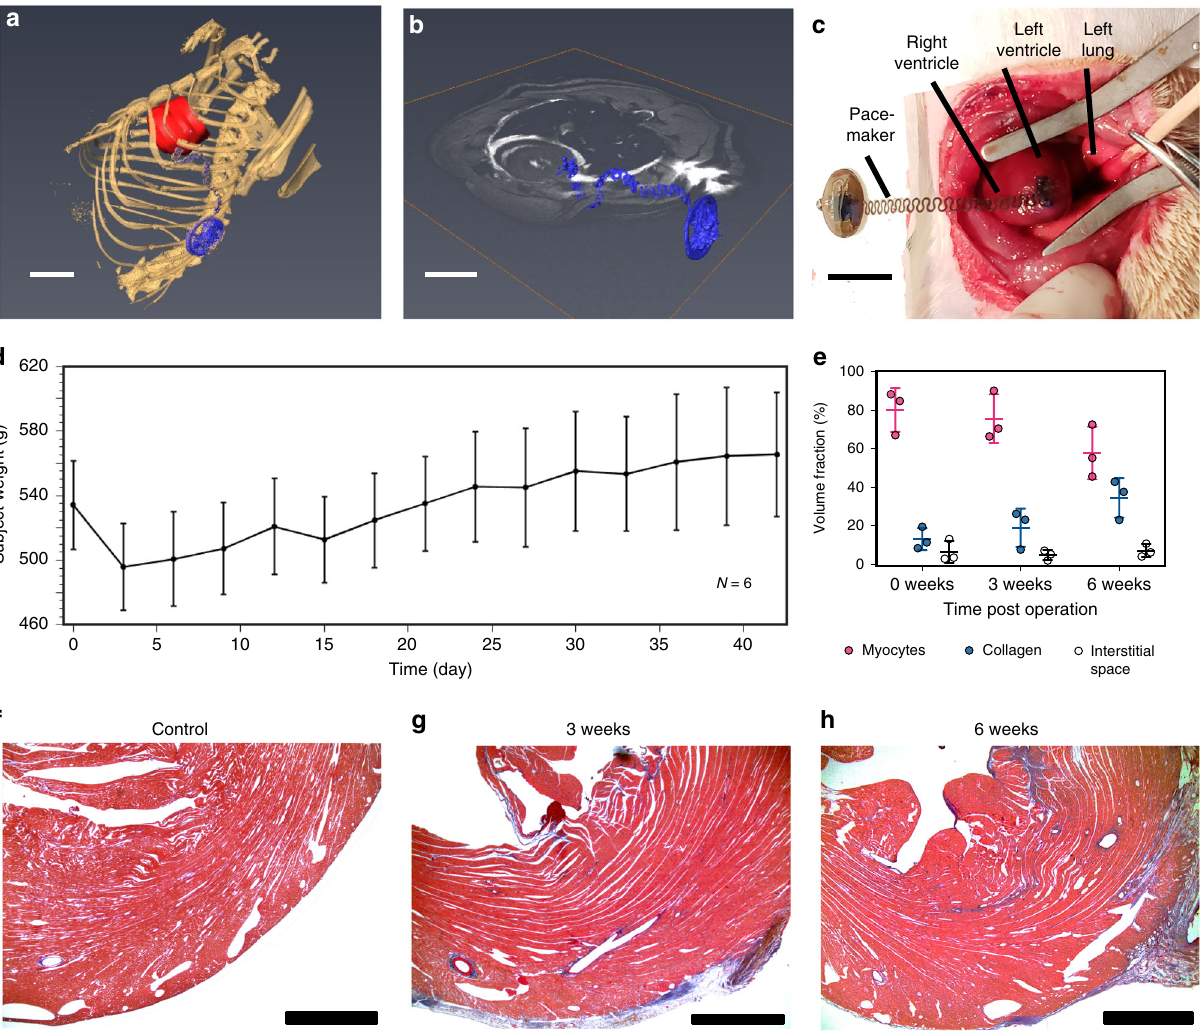
Fig. 4 Device implantation and biocompatibility. a 3D segmentation of anatomical positioning of device (blue) with respect to the rat heart (red) (scale bar 1 cm). b Anatomical positioning of the device (blue) visualized in the transverse plane (scale bar 1 cm). c The device is sutured to the anterior epicardial surface of the left ventricle of the rat (scale bar 1 cm). d Animal subjects were postoperatively weighed for 3 ( n = 3) and 6 weeks ( n = 3). Error bars indicate mean ± SD. e The transmural anterior left ventricle was stained with Masson ’ s trichrome in adult rats. No signi fi cant differences in fi brosis were found between any time points ( p < 0.05). Error bars indicate mean ± SD. f Representative images of the transmural anterior left ventricle without pacemaker implantations ( n = 3) (scale bar 1 mm) and at ( g ) 3 weeks ( n = 3) (scale bar 1 mm) and ( h ) 6 weeks after pacemaker implantation ( n = 3) (scale bar 1 (Supplementary Movie 2). The membrane potential activation clearly propagates throughout the ventricular myocardium (Fig. 5a, b). Additional information is provided in Supplementary Fig. 9. Electrical capture was simultaneously veri fi ed with ECG recordings. A clear increase in heart rate and QRS complex amplitude was observed with the onset of pacing to demonstrate that the device drives the heart rhythm (Fig. 5c).